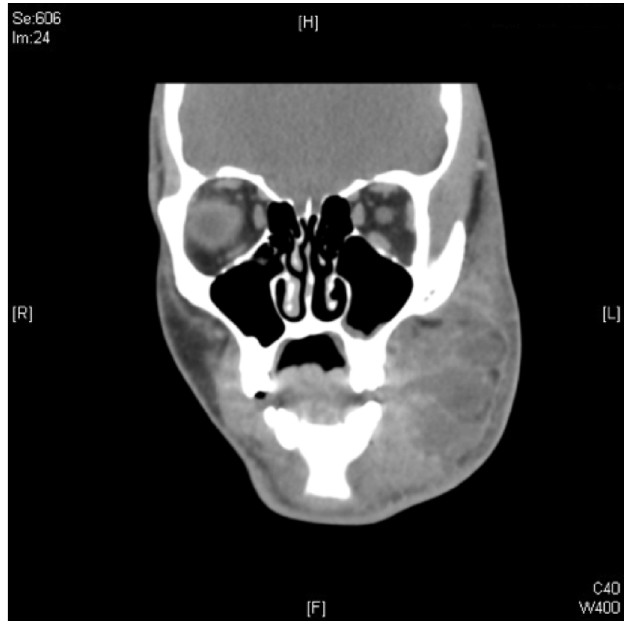
Fig. 4. Coronal CT scan with contrast administration on postoperative day 4 after the fi rst